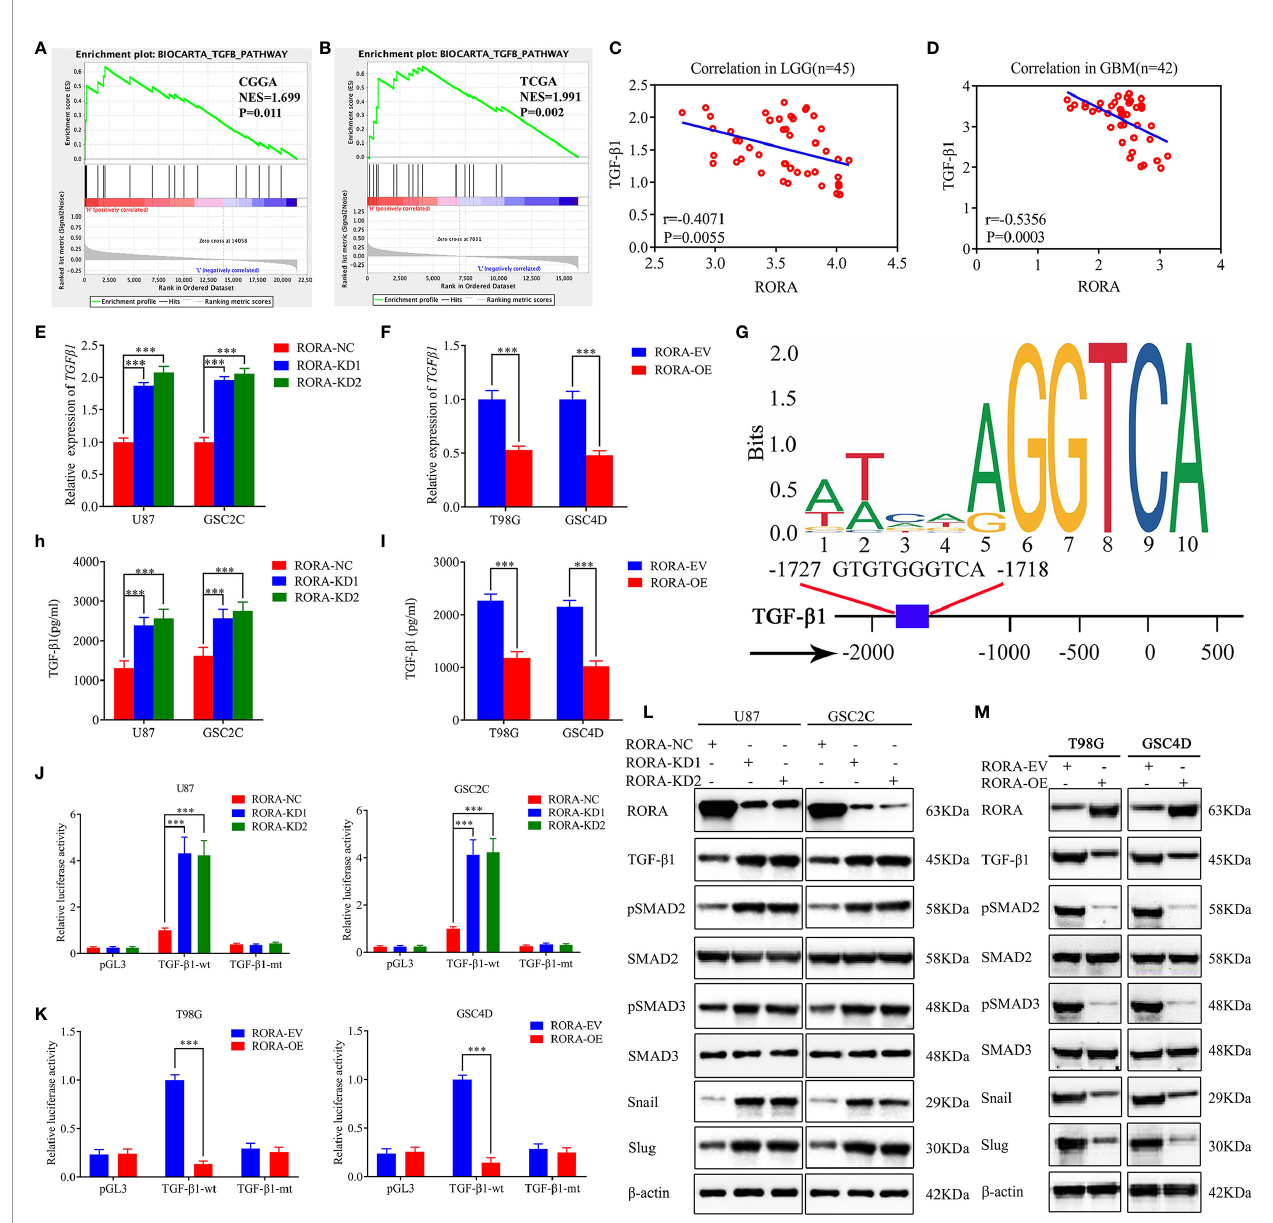
FIGURE 3 | RORA regulates the migration, invasion, and EMT of GBM by negatively affecting the TGF- b 1/Smad signaling pathway. (A, B) GSEA showing high expression of RORA correlates with the TGF- b signaling pathway in both the Chinese Glioma Genome Atlas and The Cancer Genome Atlas databases. (C, D) The relative expression correlation between RORA and TGF- b 1 in 87 cases of glioma patients was detected by RT-qPCR. (E, F) and (H, I) The expression and secretion of TGF- b 1 after RORA knockdown (E, H) or overexpression (F, I) was detected by RT-qPCR (E, F) and ELISA (H, I) . (G) Sequence motif representing the consensus RORA binding motif (JASPAR database), and Schematic representation of the human TGF- b 1 promoter region. (J, K) RORA knockdown (J) or overexpression (K) altered the luciferase promoter activities of TGF- b 1. (L, M) Western blotting showing that the downstream targets of the TGF- b 1/Smad signaling pathway were regulated after RORA knockdown (L) or overexpression (M) . NC, negative control; KD, knockdown; EV, empty vector; OE, overexpression. All data are expressed as the mean ± SD (three independent experiments). ***P <